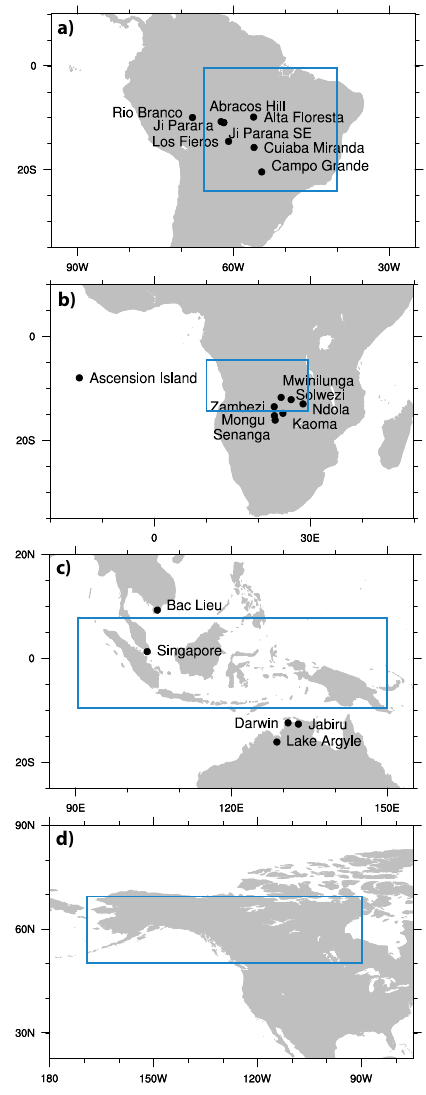
Fig. 1. Regional maps of AERONET stations (black dots) and MISR/MODIS scaling areas (blue boxes) for (a) South Amer- ica (SAM), (b) southern Africa (SAF), (c) equatorial Asia (EAS) and (d) boreal North America (BNA). There were no suitable AERONET stations in